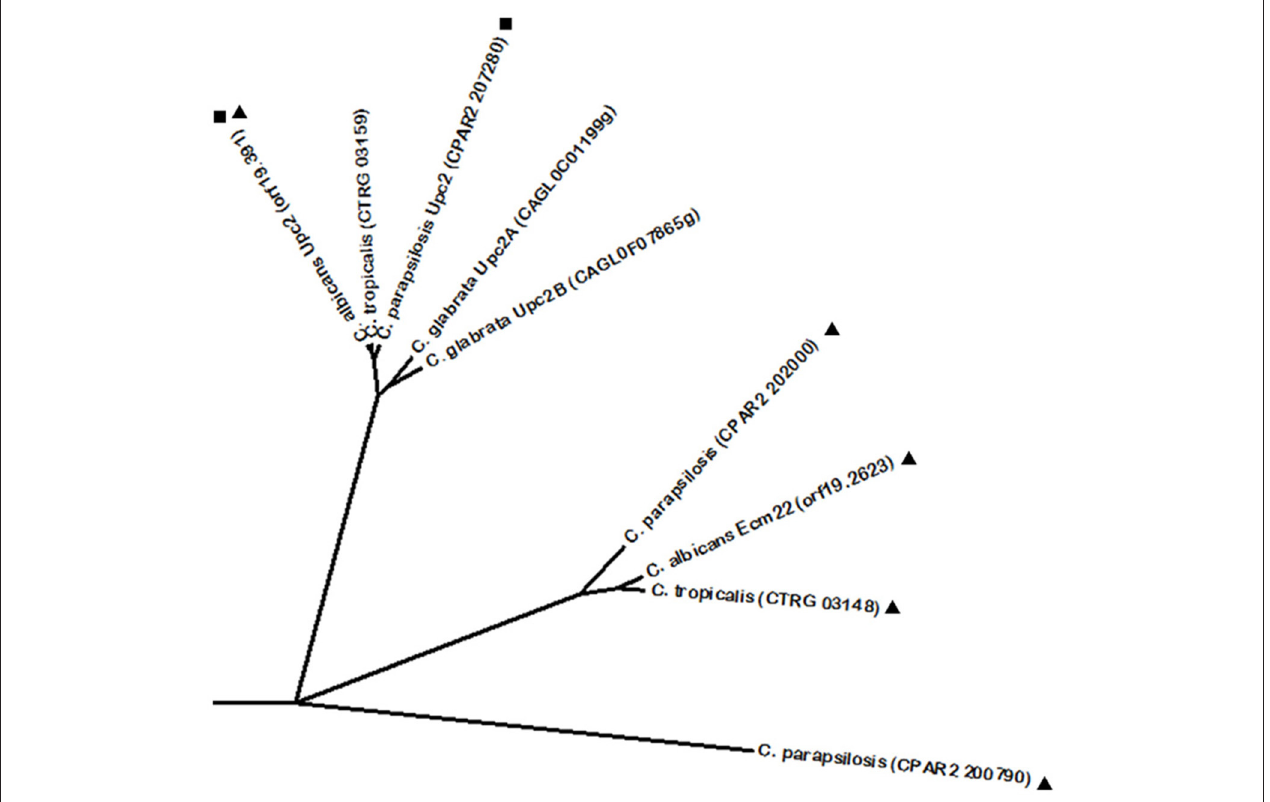
FIGURE 2 | Phylogenetic analysis of the C. albicans Upc2 and Ecm22 homologs. Phylome predicted homologs of Upc2 are marked with ( (cid:4) ). Phylome predicted homologs of Ecm22 are marked with ( N ). Unmarked branches represent additional proteins showing some degree of similarity identified by BLASTp ( E < 10 − 50 ). The tree was constructed using the Molecular Evolutionary Genetics Analysis (MEGA 7) software (Kumar et al., 2016). Multiple alignments of the amino acid sequences were calculated by ClustalW algorithm (Sneath and Sokal, 1973). The tree is drawn to scale, with branch lengths in the same units as those of the evolutionary distances used to infer the phylogenetic tree. The evolutionary distances were computed using the JTT matrix-based method ( Jones et al., 1992) and are in the units of the number of amino acid substitutions per site. The rate variation among sites was modeled with a gamma distribution (shape parameter =